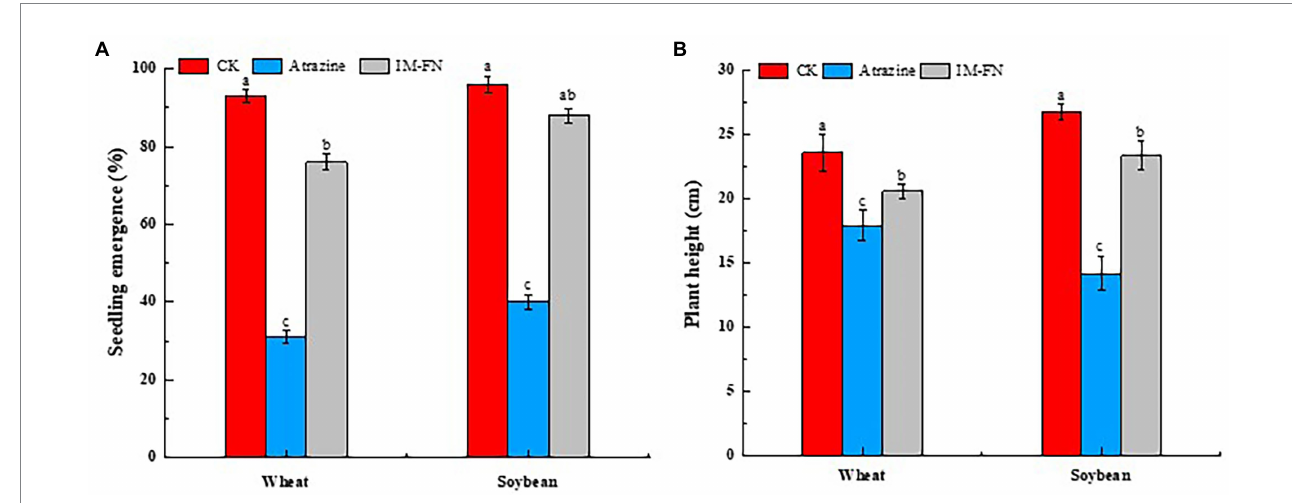
FIGURE 9 Seedling emergence percentage in 3 days (A) and plant height in 15 days (B) of wheat and soybean plants grown in soils treated with immobilized bacterial mixture (IM-FN). Different letters (a, b, and c) indicate significant differences between different treatments at the level of p <